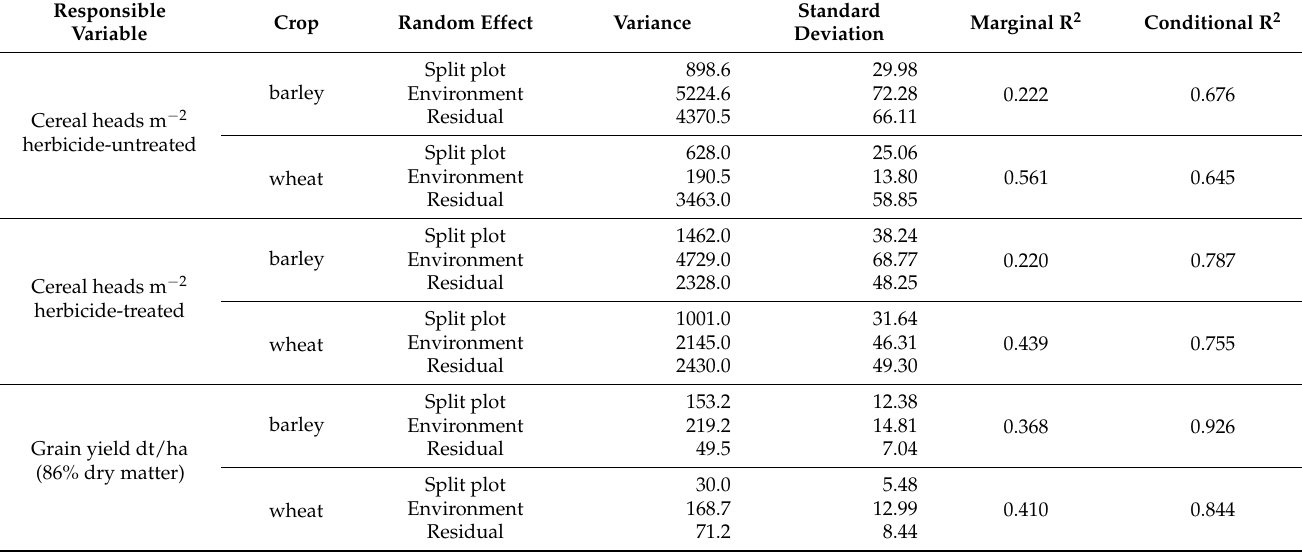
Figure 3. A. myosuroides plants in herbicide-treated areas [m −2 ] in winter barley and winter wheat depending on sowing and used active ingredient(s) (winter wheat: 500 g cinmethylin ha −1 , winter barley: 250 g cinmethylin ha −1 + 144 g flufenacet ha −1 , both crops: 240 g flufenacet + 120 g diflufenican ha −1 ), box = 25% and 75% quartile, bold line = median, error bars = 5th and 95th percentile, black circles illustrate outliers, different letters indicate significant differences between sowing date or herbicide treatment (bold letters: winter barley), p ≤ 0.05, Tukey -HSD-Test. In plots where pre-emergence herbicides were applied in mid or the end of October, fewer A. myosuroides heads were counted (Figure 4). Although the density of A. myosu- Table 7. Summary of crop-specific linear mixed effect models for the responsible variables, cereal roides was similar in winter barley and in winter wheat in autumn, fewer A. myosuroides heads (herbicide-treated and untreated areas) as well as the grain heads were counted in winter barley in spring. The number of heads did not differ signif- icantly between the herbicide treatments in both winter barley and winter wheat.